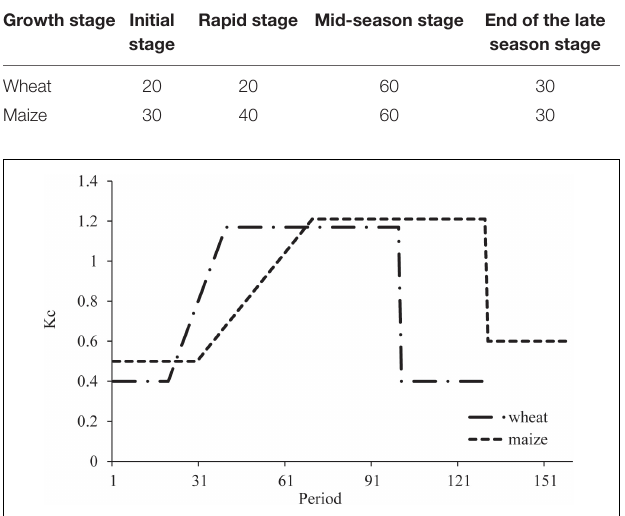
FIGURE 3 | Crop coefficients K c curves of wheat and maize in